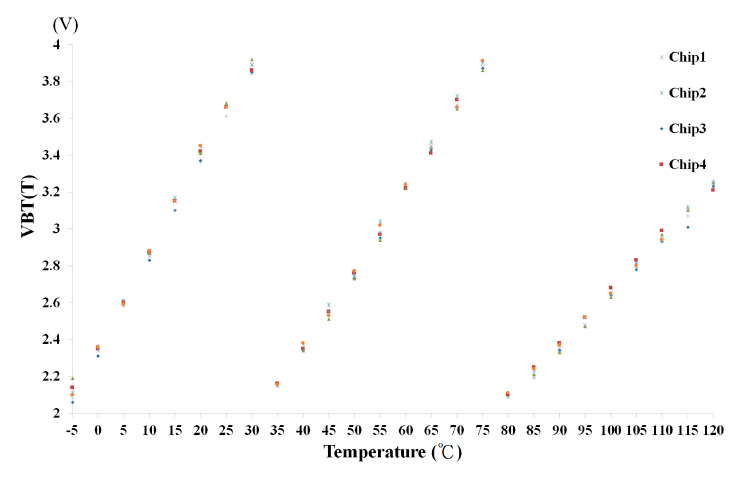
Figure 14. The summary of measurement results of the proposed temperature